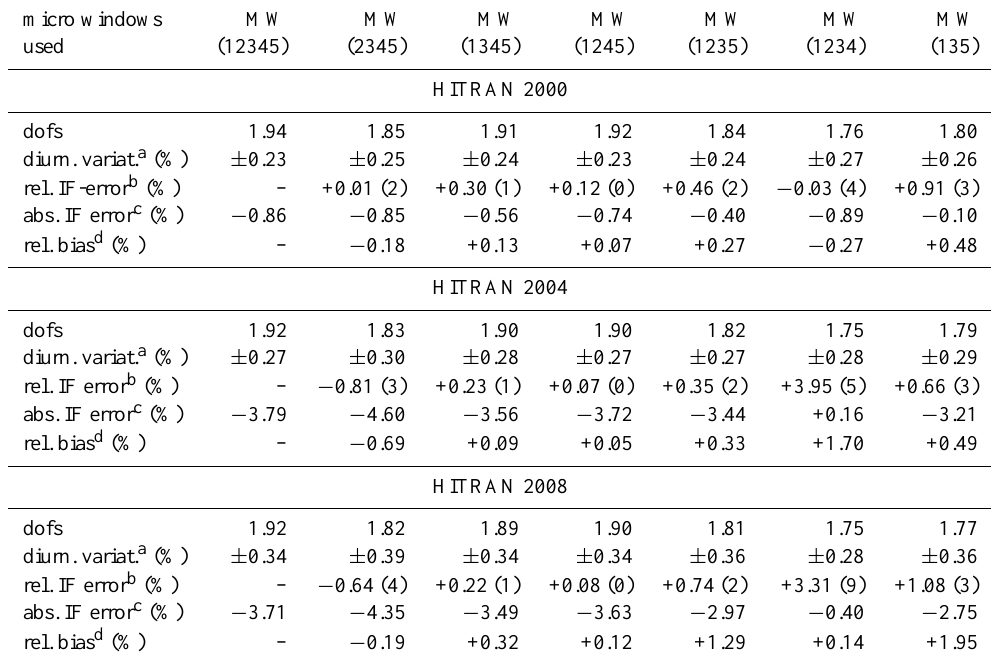
Table 5. Effect from dropping individual micro windows using 3 different HITRAN versions for the test station Garmisch; impact on information content (dofs), interference errors, and diurnal variation.